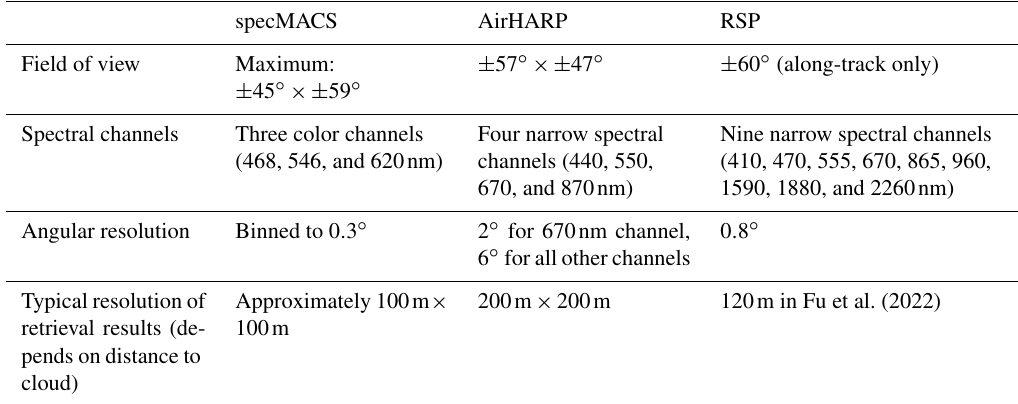
Table 1. Technical details of specMACS, AirHARP (McBride et al., 2020), and RSP (Alexandrov et al.,